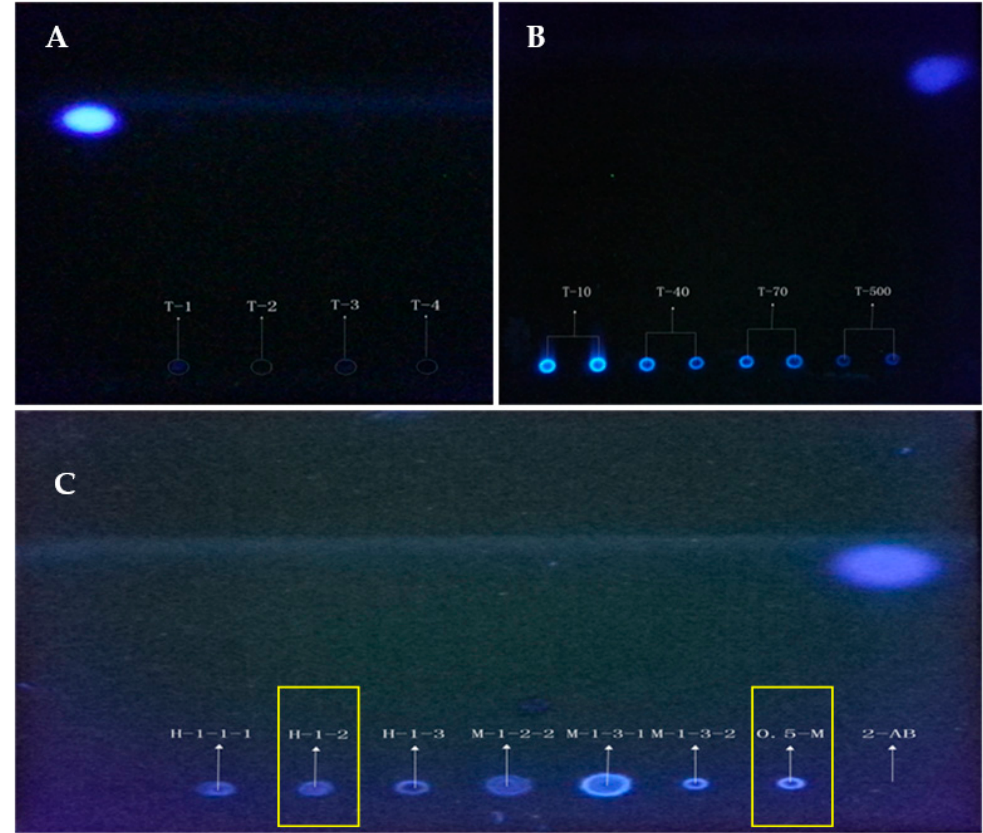
Figure 3. TLC identification method for polysaccharide-2-AB. T-1 and T-2 are PHP H-1-2 and PHP 0.5MSC-F , T-3 and T-4 are NaBH 4 and the blank solvent ( A ). Fluorescence spots with dextran T-500, T-70, T-40 and T-10 derivatives with 2-AB are shown ( B ). Fluorescence spots of 7 kinds of polysaccharide-2-AB are shown, and the yellow rectangle display shows the study of PHP H-1-2 -2AB and PHP 0.5MSC-F -2-AB presented in this article ( C ). In every one of the TCL plates, the uppermost blue spots are all 2-AB fluorescence.